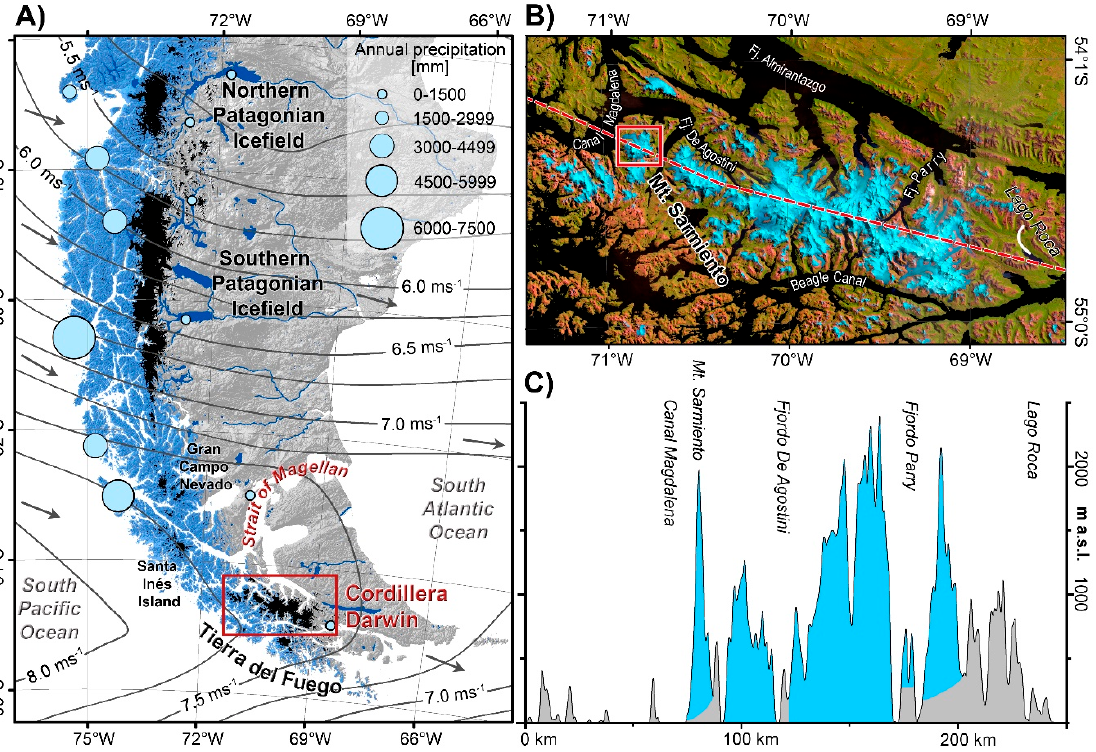
Figure 1. ( A ) Overview of the Patagonian Andes and the Tierra del Fuego with its main ice bodies (black) [8]. On the upwind side of the mountain ranges, blue shades display precipitation amounts exceeding 1000 mma − 1 [18]. Light-blue-filled circles and their diameters represent the location and the corresponding annual precipitation of climate stations (data obtained from the Dirección Meteorológica de Chile (DMC) and the Servicio Nacional de Meteorología (SMN)). Grey isotachs represent the mean annual wind speed in m per second (ms − 1 ), and grey arrows, the mean annual wind direction for the period between 1980 and 2018 at 1000 mbar pressure level [19]. ( B ) The fjord-rich west–east striking mountain range of the Cordillera Darwin includes the largest icefield of Tierra del Fuego (Landsat-TM image mosaic, bands 5-4-3, acquisition date: 14-02-2005). ( C ) According to the west–east elevation profile of the Cordillera Darwin (transect displayed as red line in B), Monte Sarmiento is the first prominent peak located on the windward, hyper-humid side of the mountain range; glacierized terrain is displayed in blue.